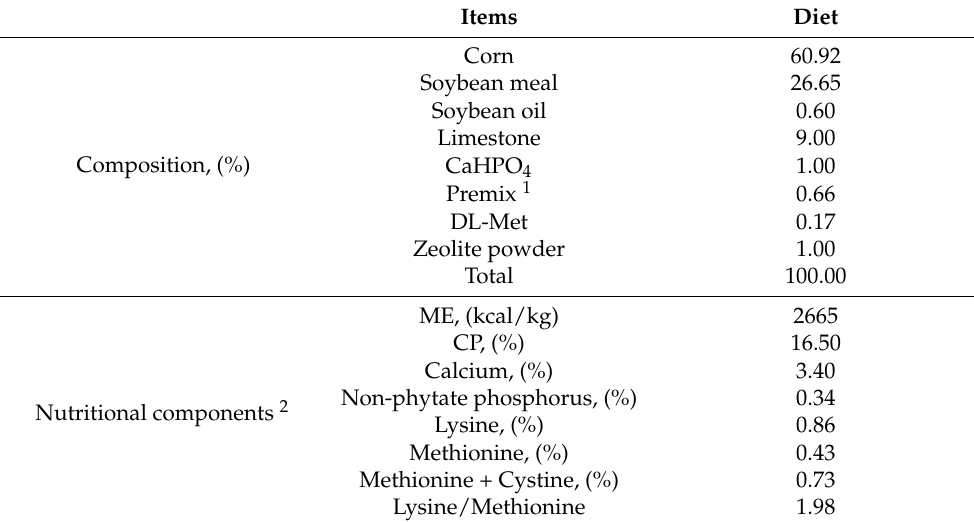
Nutritional components